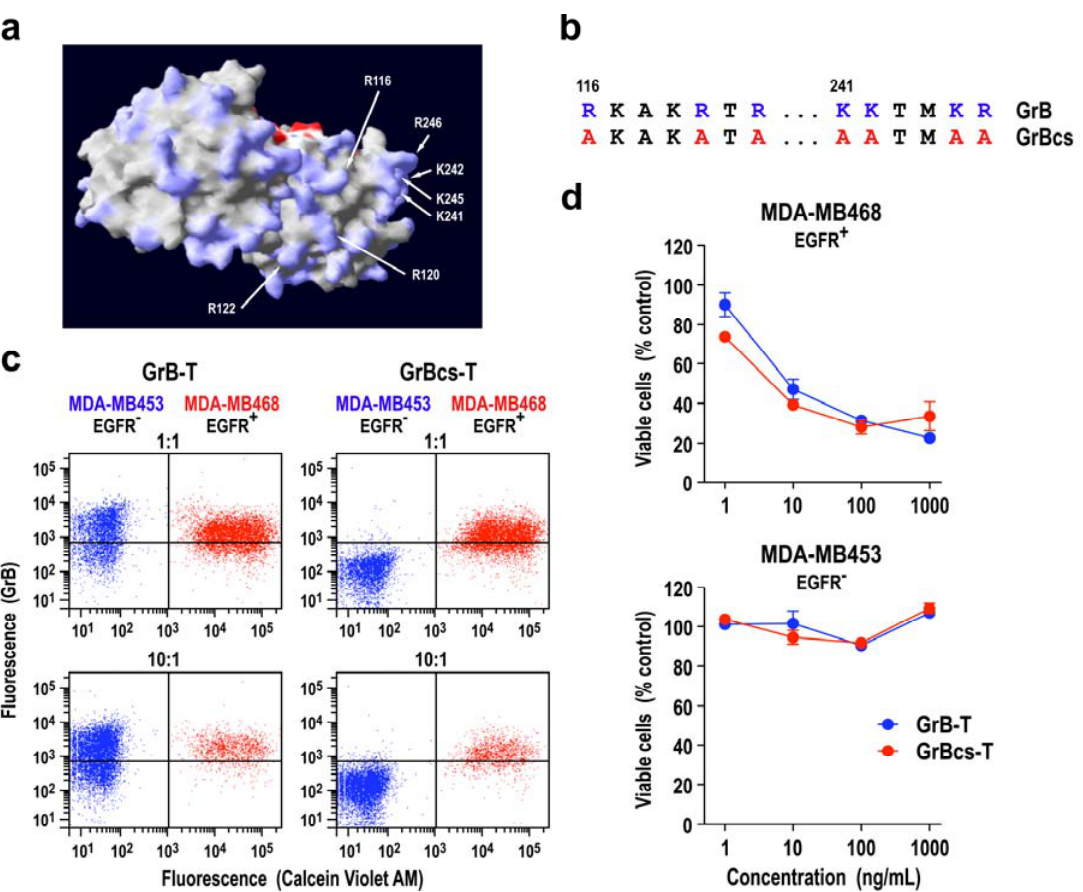
Figure 3. ( a ) Electrostatic surface potential of granzyme B. Positively charged areas are represented in blue. Residues mutated in the charge-modified derivative GrBcs are indicated. The model is based on the crystal structure of human GrB (1FQ3) [72] (generated with DeepView Swiss-PdbViewer; spdbv.vital-it.ch). ( b ) Positively charged residues within GrB (indicated in blue) were replaced by alanine residues (indicated in red) to obtain the charge-modified derivative GrBcs [38,66]. ( c ) Differential cell binding of targeted GrB proteins consisting of TGF α fused to the C-terminus of wildtype GrB (GrB-T) or charge-modified GrBcs (GrBcs-T). Unlabeled EGFR-negative MDA-MB453 breast carcinoma cells (blue) were mixed with fluorescently labeled EGFR-positive MDA- MB468 breast carcinoma cells (red) at a ratio of 1:1 or 10:1 prior to incubation with GrB-T (left panels) or GrBcs-T fusion proteins (right panels). Cell binding was analyzed by flow cytometry with Alexa Fluor 647-conjugated GrB-specific antibody as described [38]. ( d ) Cytotoxic activity of surface charge-modified GrBcs-T. EGFR-positive MDA-MB468 (upper panel) and EGFR-negative MDA-MB453 cells (lower panel) were treated with the indicated concentrations of purified GrB-T (blue circles) or GrBcs-T protein (red circles) for 14 hours in the presence of 50 µM chloroquine. The relative number of viable cells in comparison to controls treated only with chloroquine was determined in cell viability assays as described